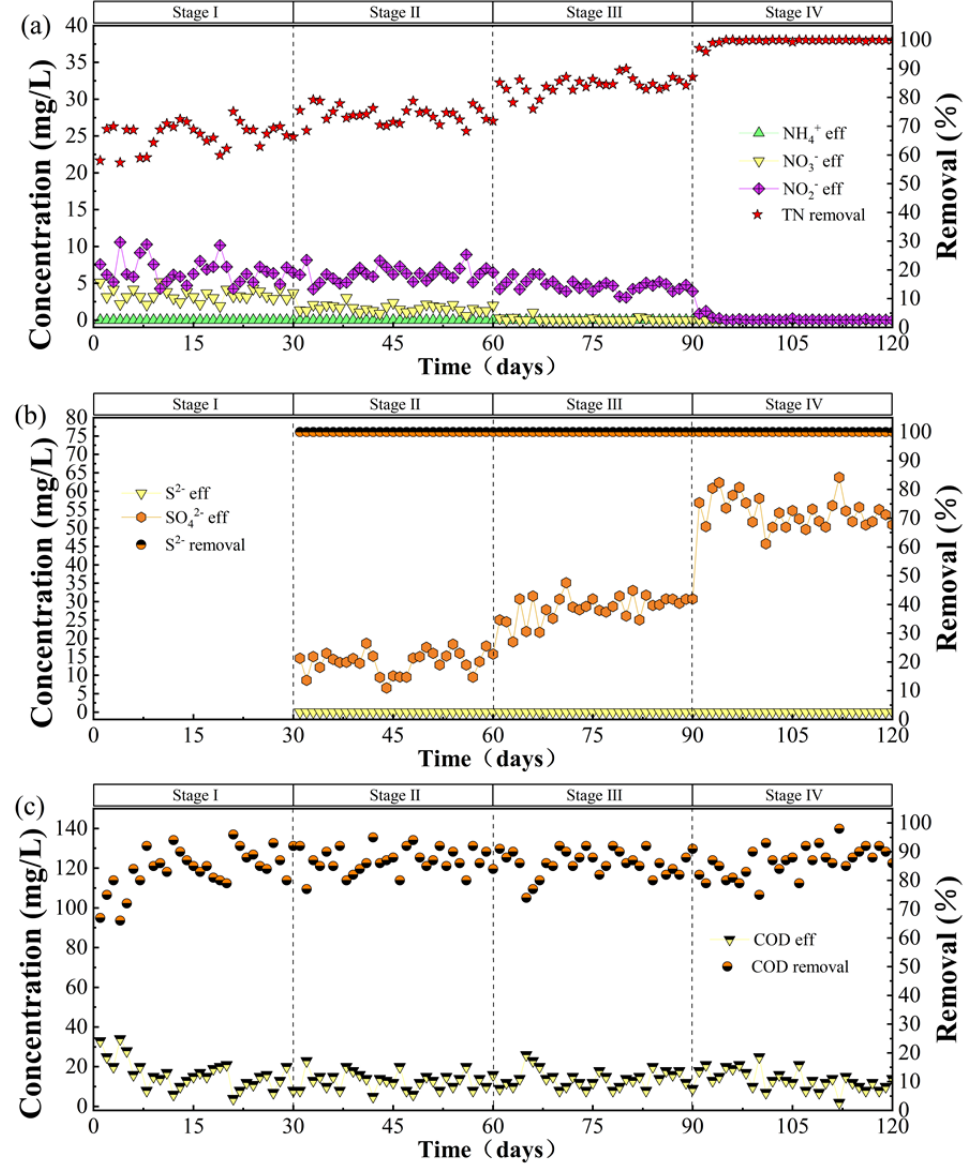
Figure 2. Performance of the system during the different stages: ( a ) the concentration changes of NO 3 − -N, NO 2 − -N, NH 4+ -N in the effluent, and the removal of TN; ( b ) the concentration changes of S 2 − and SO 42 − in the effluent, and the removal of S 2 − ; ( c ) the concentration changes of COD in the effluent, and the removal of COD.